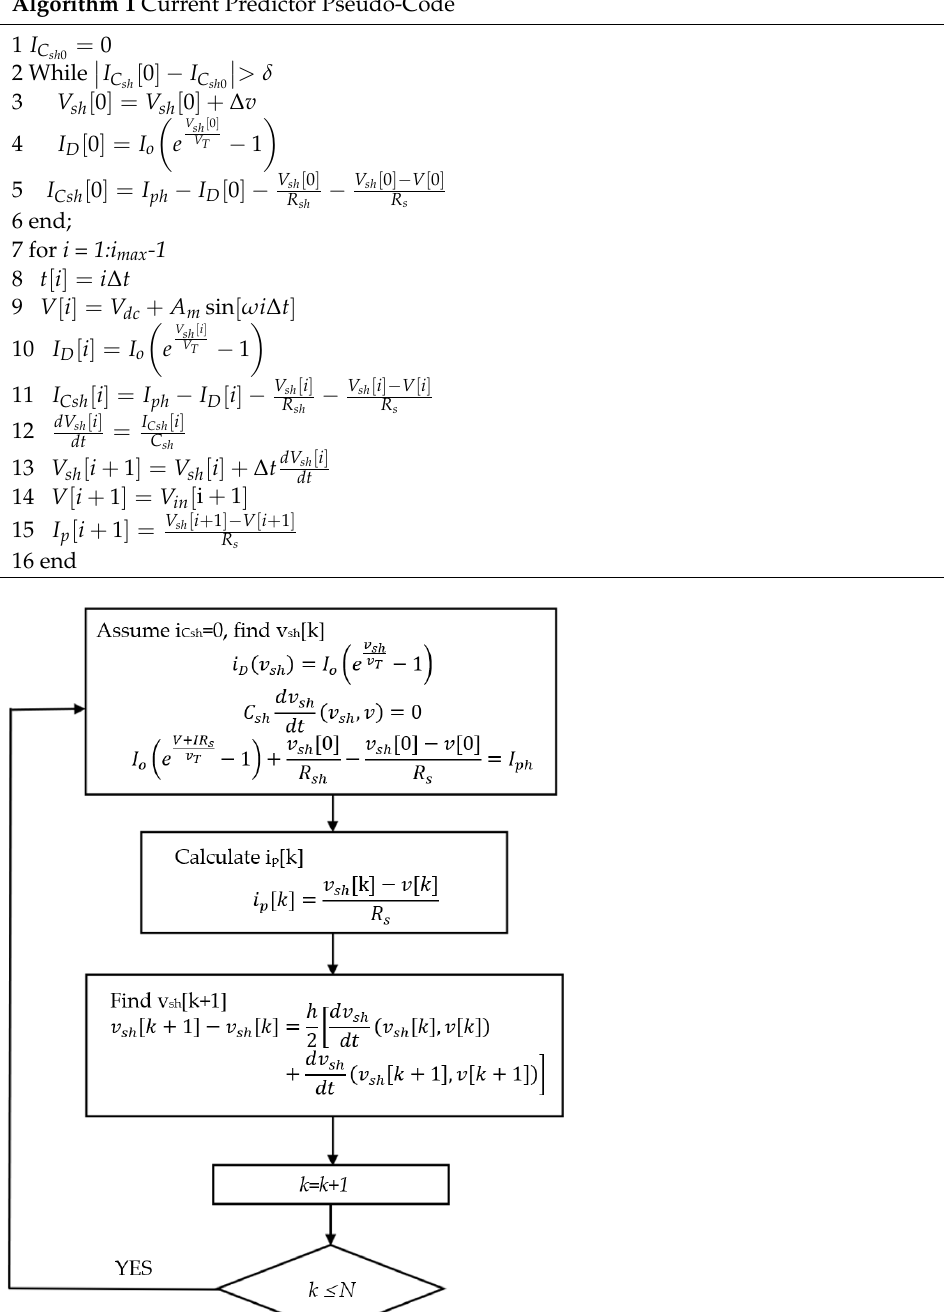
Algorithm 1 Current Predictor Pseudo-Code